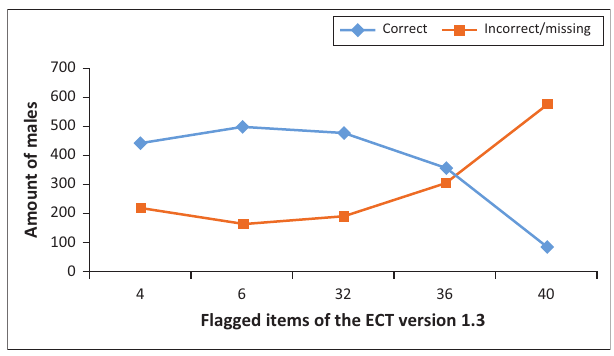
FIGURE 2: Male performance on flagged items of English Comprehension Test, version 1.3.